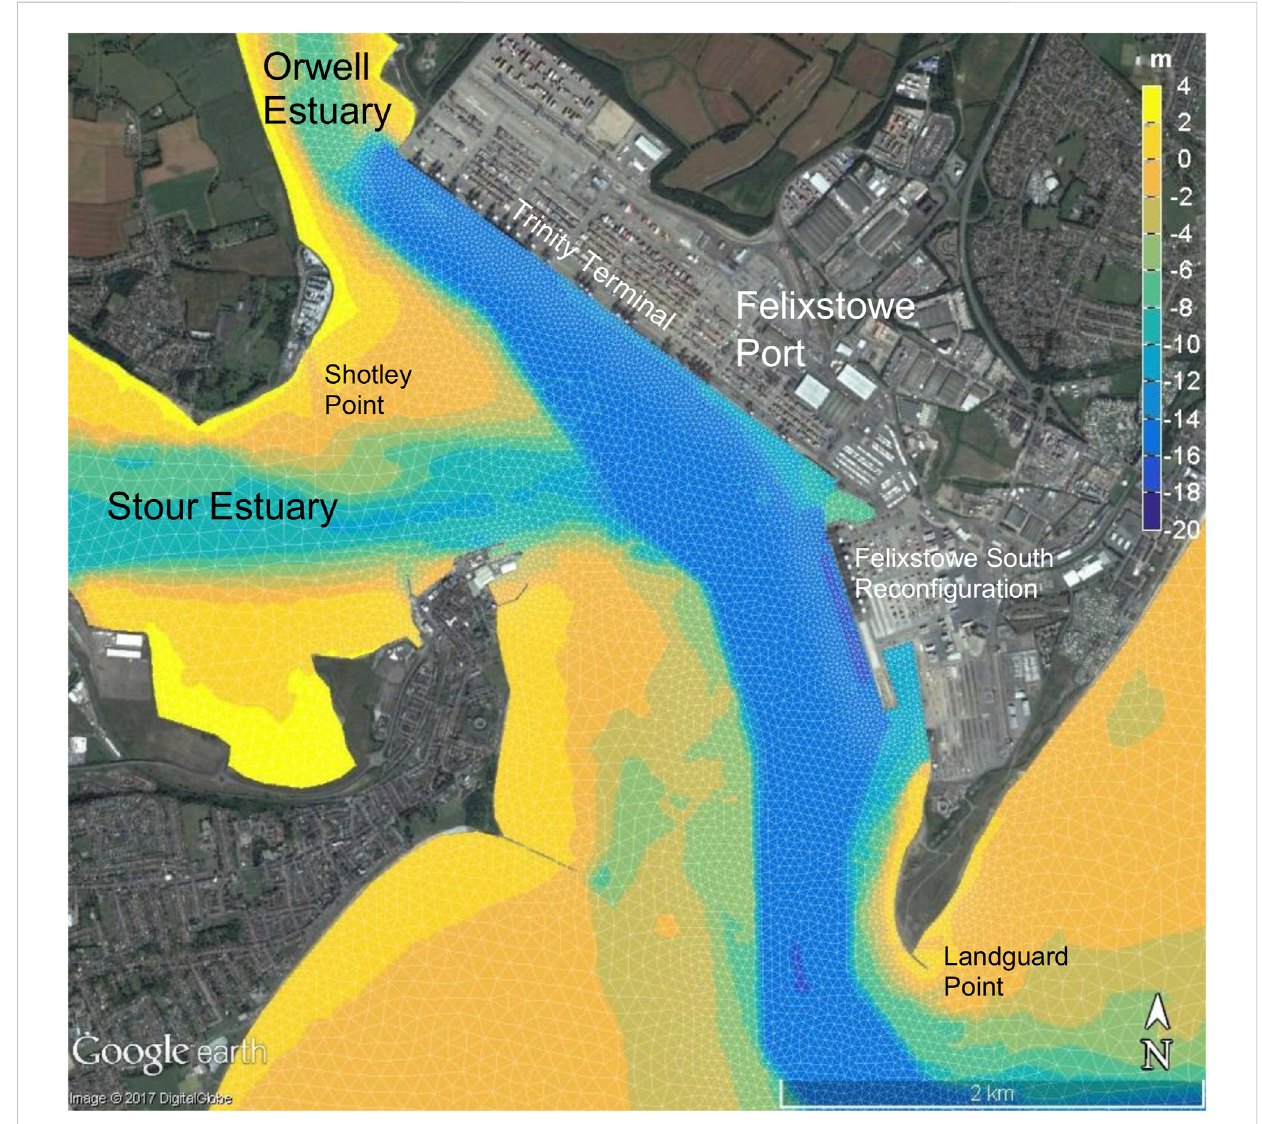
FIGURE 7 Model geometry and mesh within Harwich